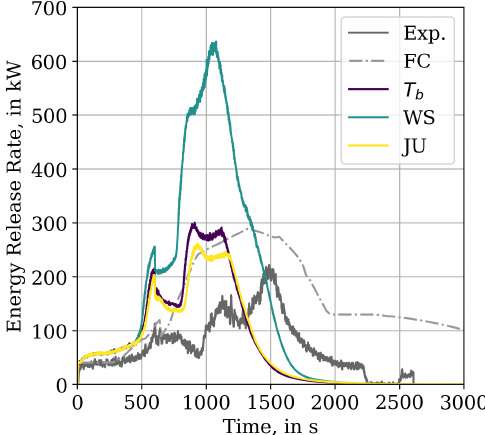
Figure A14. Comparison between energy release rates of MT3 simulation of the best parameter set of IMP T b . T b : JURECA, Linux, FDS 6.5.3; WS: Workstation, Windows 10, FDS 6.5.3; JU: JURECA, Linux, FDS 6.7.0.